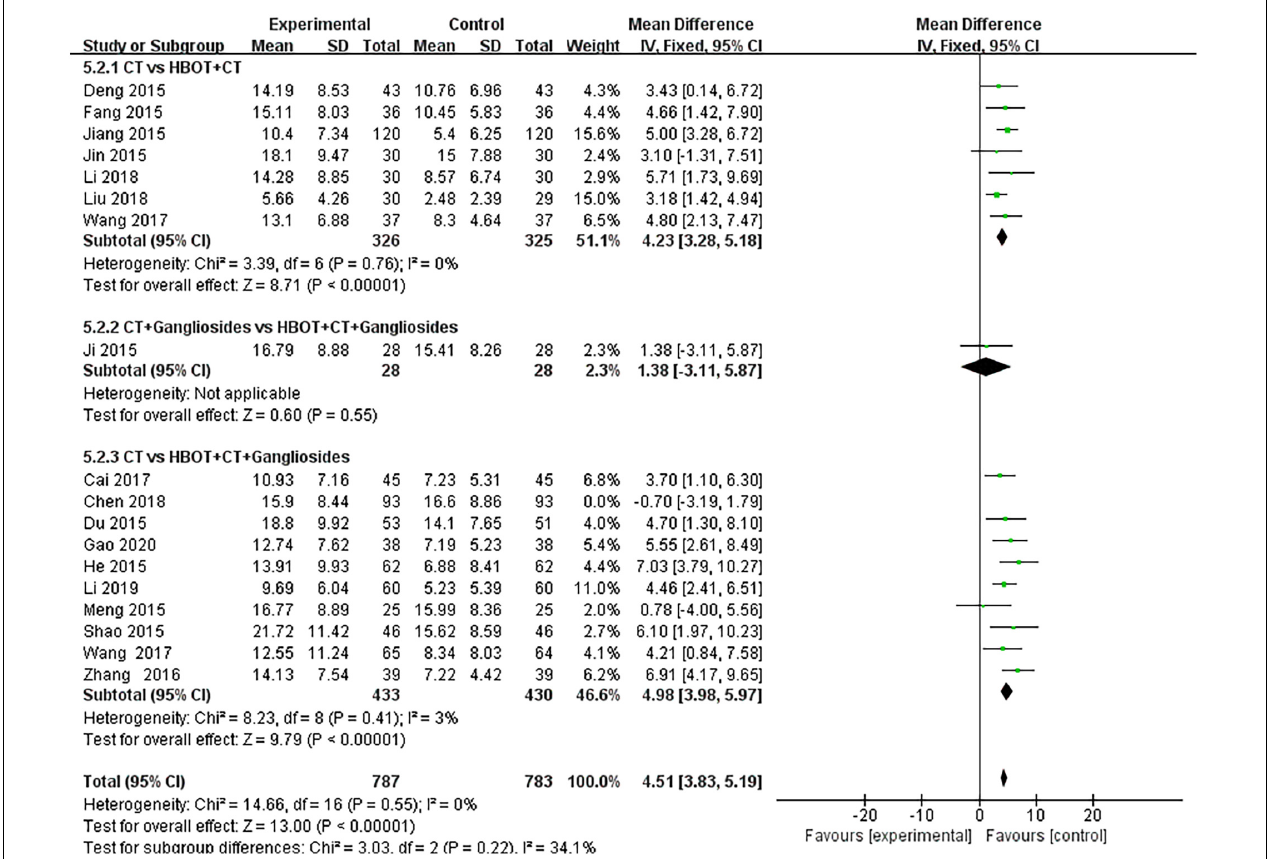
FIGURE 6 | Subgroup analysis of NBNA score: (1) CT vs. HBOT + CT; (2) CT + Gangliosides vs. HBOT + CT + Gangliosides; (3) CT vs. HBOT + CT +